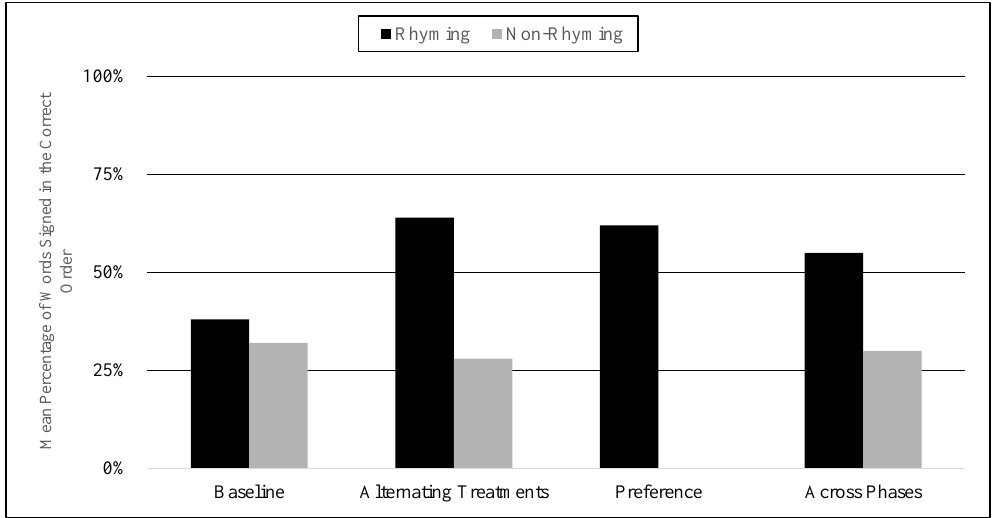
Figure 6. Mean Percentage of Words Signed in the Correct Order Across Phases in Some Vocabulary/Delayed and Most Vocabulary/Typical Language Groups. 6.3. Visual Graphs Visual graphs showing student performance in the rhyming and non-rhyming conditions with data overlapped for visual comparison are presented for words signed correctly and words signed in the correct order during recitation. The order of students is listed based on age, starting with the